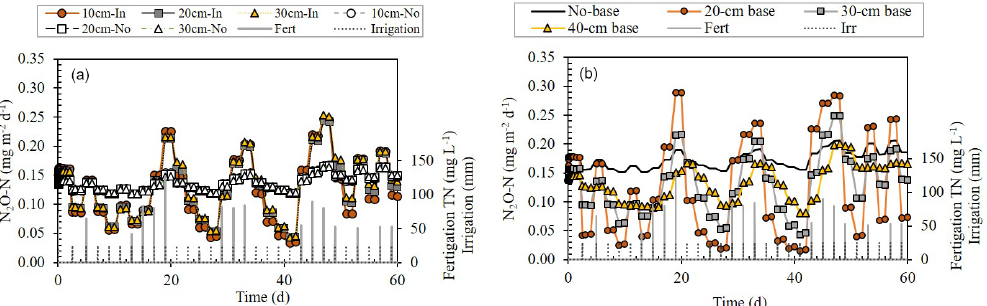
Figure 5. Simulation results of the change over time in NO − sizes (i.e., no base, 20, 30, and 40cm i.d.) with a dripper at their centers. Total nitrogen (TN) concentration in the fertigation solution is the sum of NO − -N and NH + -N concentrations. 3 4